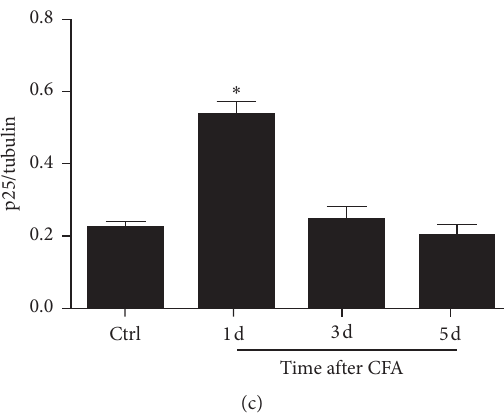
Figure 5: p25 but not p35 was markedly increased in the spinal cord. Compared with the control group treated with intraplantar injection of saline, p25 expression was significantly increased from day 1 after intraplantar injection of CFA. However, p35 expression was not significantly increased day 1 after intraplantar injection of CFA as compared with the control group treated with intraplantar injection of saline. Data shown represent mean ± SEM; ∗ P < 0 . 05; n � 4/group.